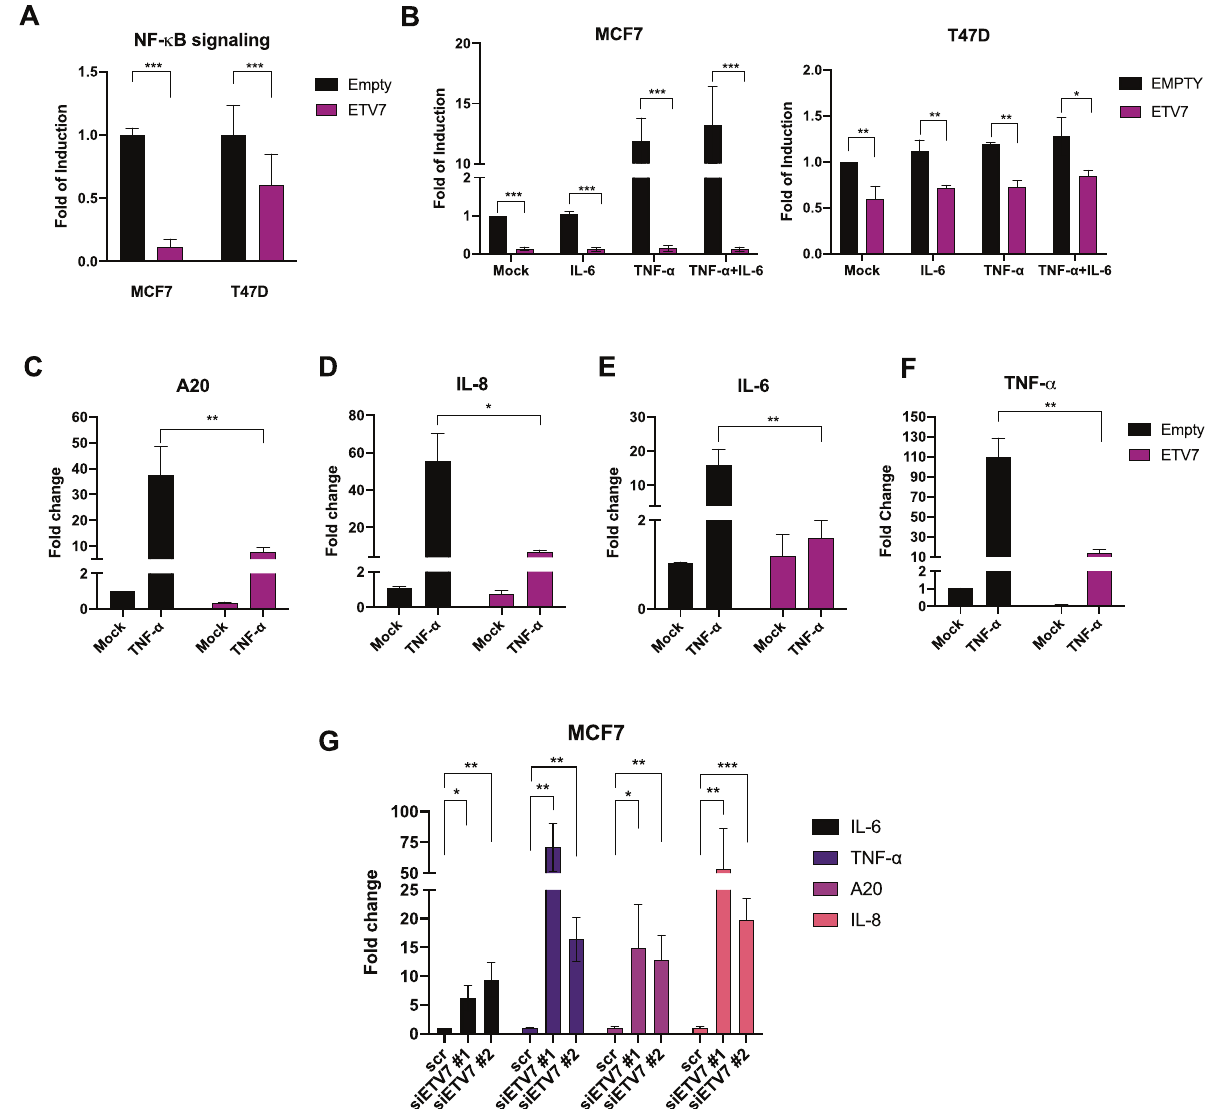
Fig. 3 ETV7 reduces NF- κ B signaling by repressing TNFRSF1A. A Gene reporter assays in MCF7 and T47D cells over-expressing ETV7 or its empty counterpart transiently transfected with the pGL3-NF- κ B reporter plasmid. Data is normalized using the Renilla reniformis